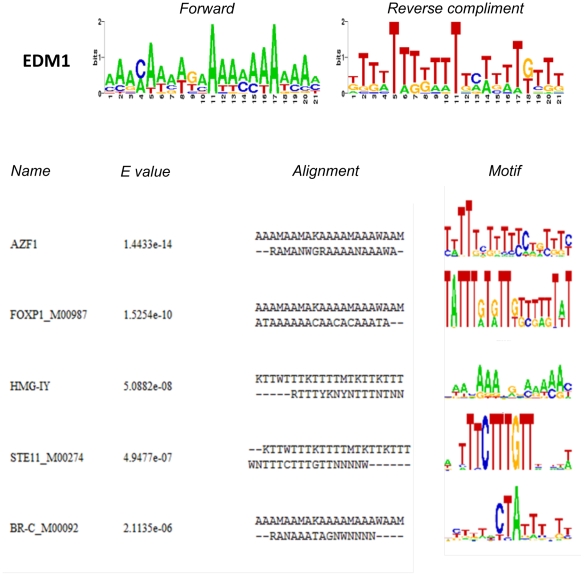
Analysis of similarities between EDM1 and eukaryotic transcription factor binding sites with the STAMP tool.The five top changes and respective significance values are shown with E value, sequence alignment and logo for each.